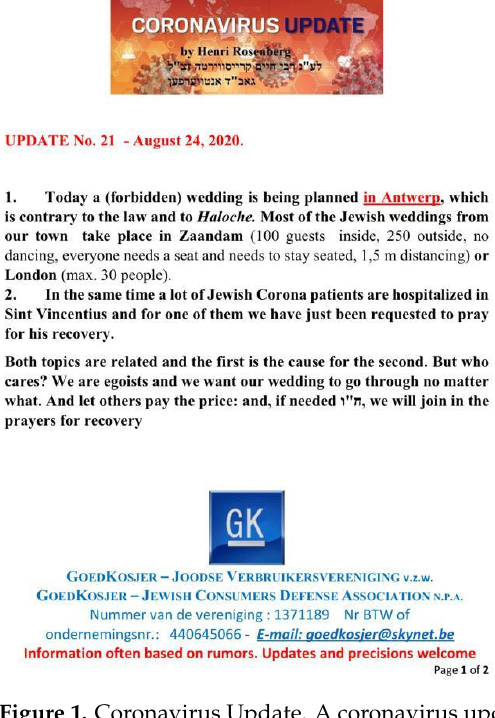
Figure 1. Coronavirus Update. A coronavirus update by Henri Rosenberg about social distancing violations in Antwerp posted on Facebook (Source: https://www.facebook.com/media/set/?set=a.10156927801881105&type=3, accessed on 24 August